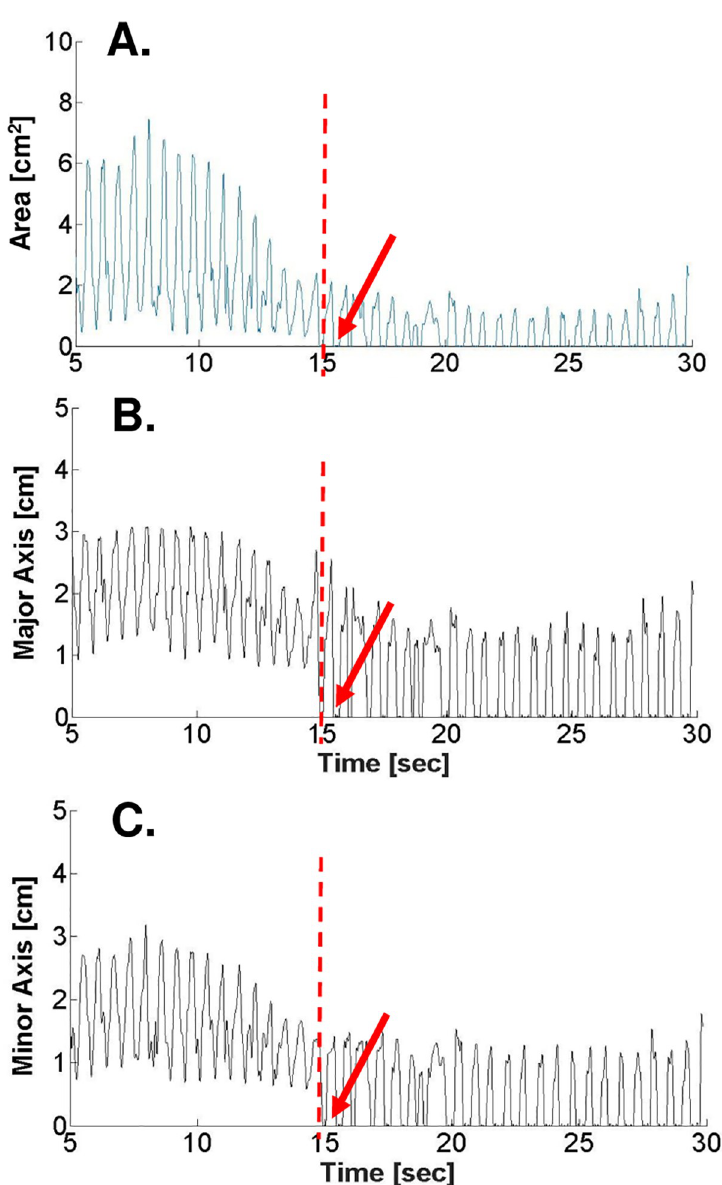
Fig 6. Plots of LV apical area (A) , Major axis length (B) , and Minor axis length (C) of a case showing segmental collapse where LVA < 0.25 cm 2 after time = 15 sec as indicated by a red